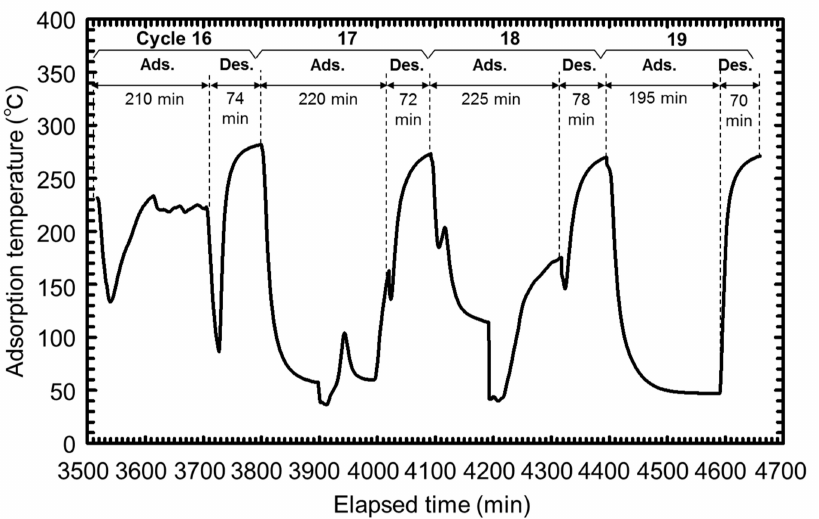
Figure 8. Time-dependent temperature in the adsorption chamber packed with 80 kg of adsorbent pellets in cycles 16 −